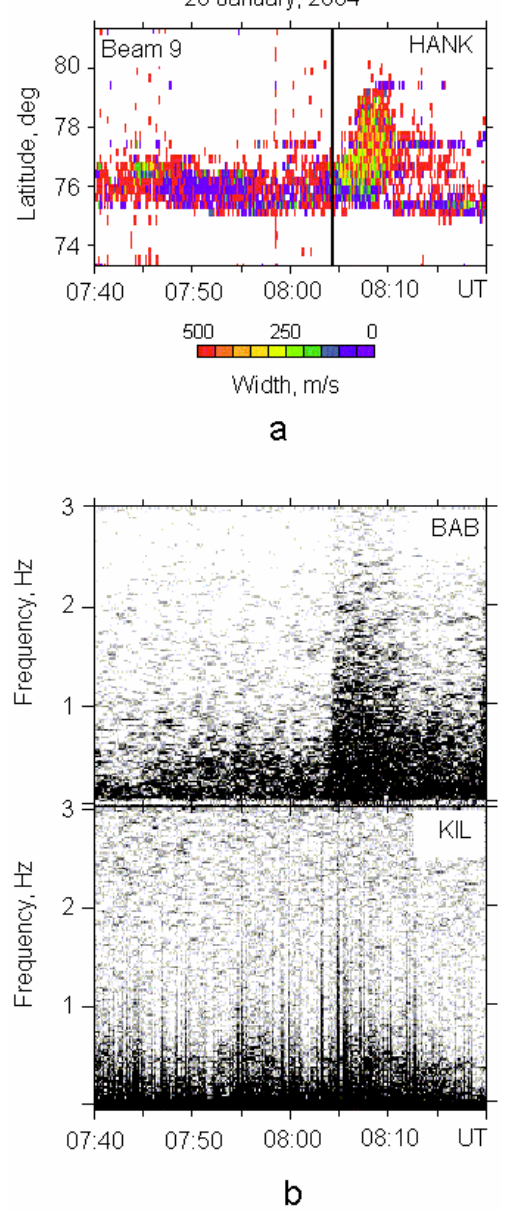
Fig. 8. (a) Appearance of ionospheric irregularities in CUTLASS and (b) induction magnetometer data. The locations of magnetometers BAB and KIL are shown in Fig. 4a.